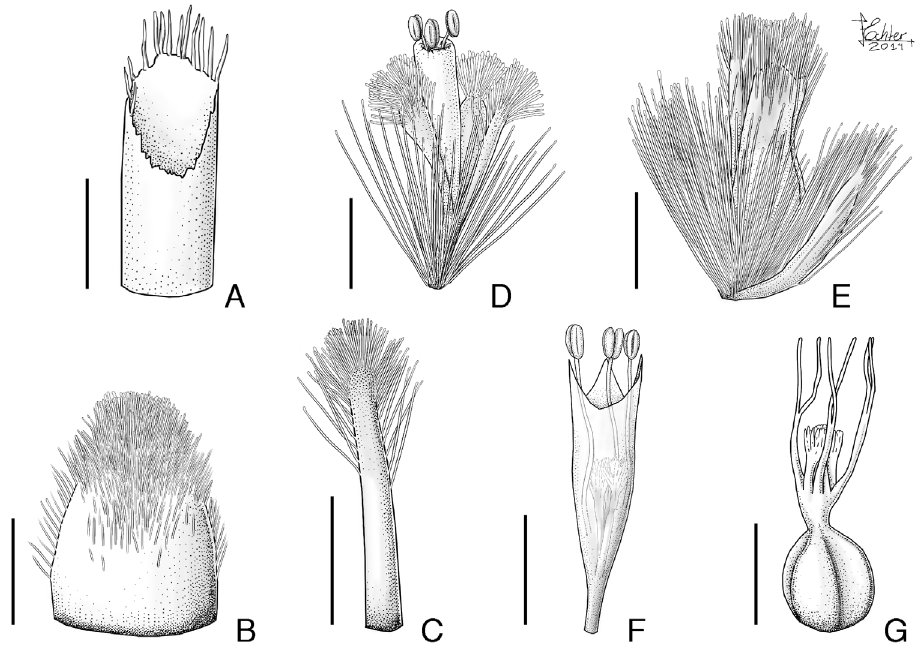
Figure 1. Illustration of Paepalanthus serpens Echtern. & Trovó: A Spathe apex B Involucral bract abaxial surface C Floral bract abaxial surface D Staminate flower E Pistillate flower with floral bract F Staminate flower with pedicel and sepals removed, at early anthesis G Gynoecium (Drawn from the holotype by L.